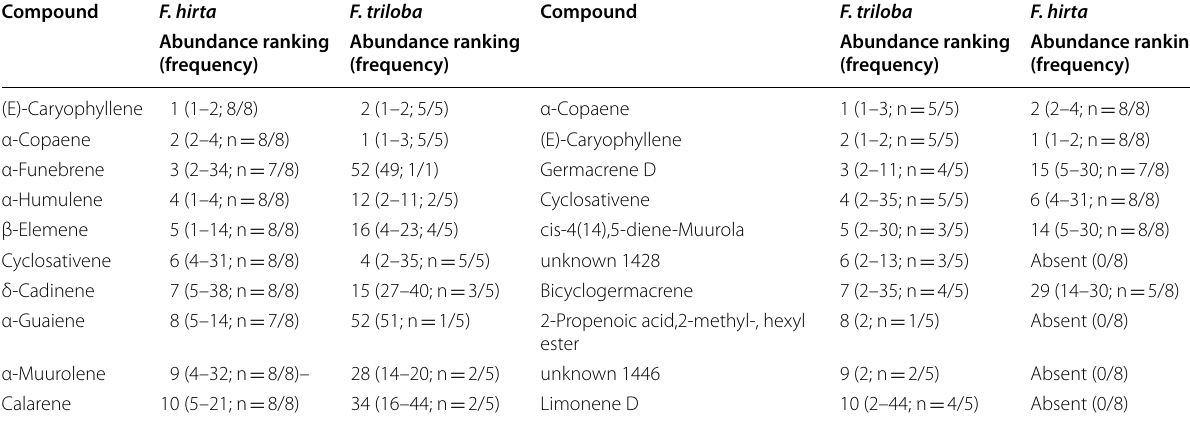
Each fig was from a different parent tree